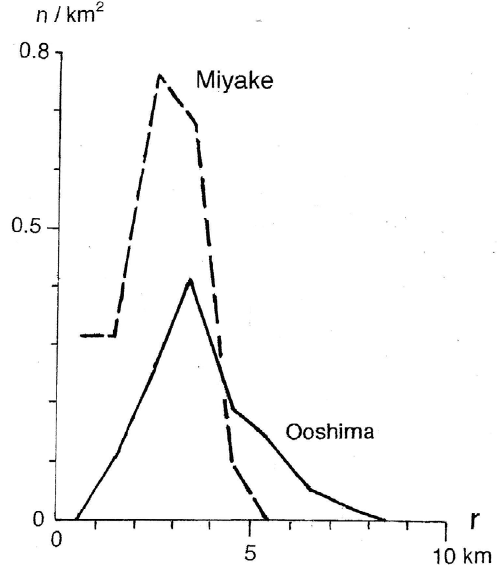
Figure 6. Spatial density distribution (n/km 2 ) of parasitic vents on Miyake and Ooshima against radial distance from the central axes of respective